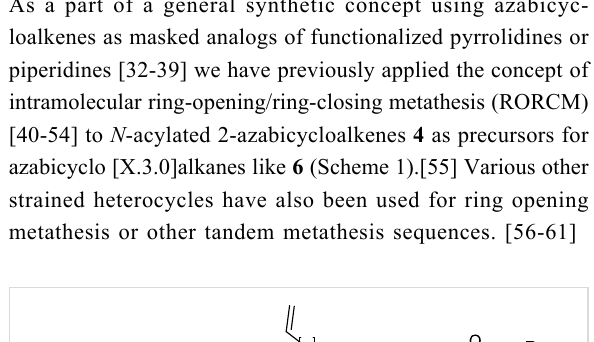
thesis are well known for their broad functional group